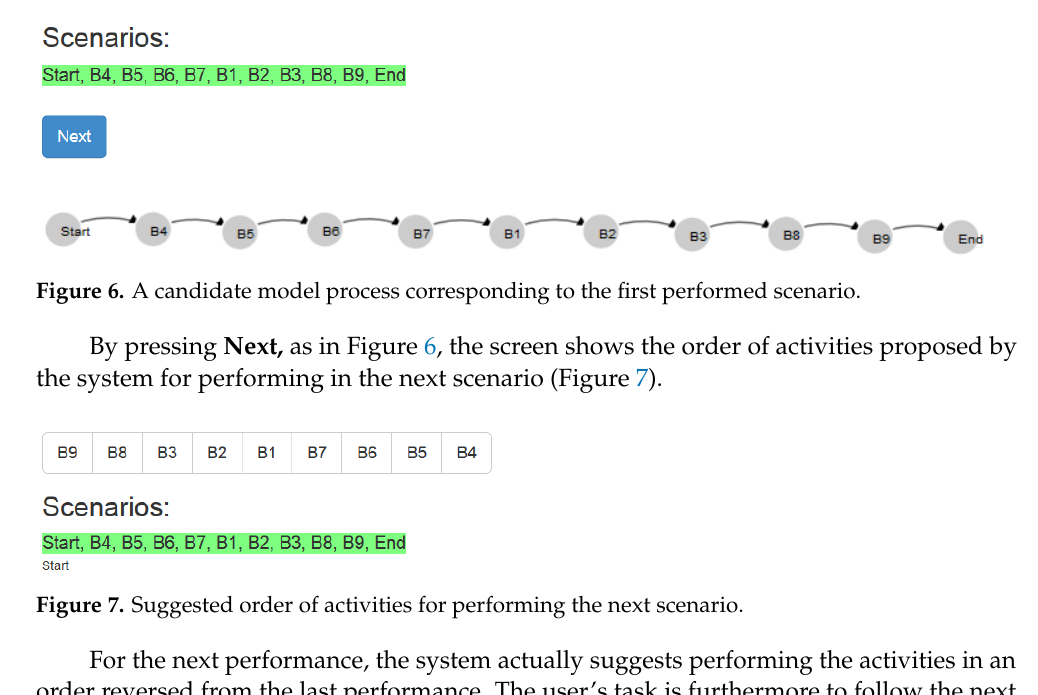
Figure 5. Performing the first scenario.